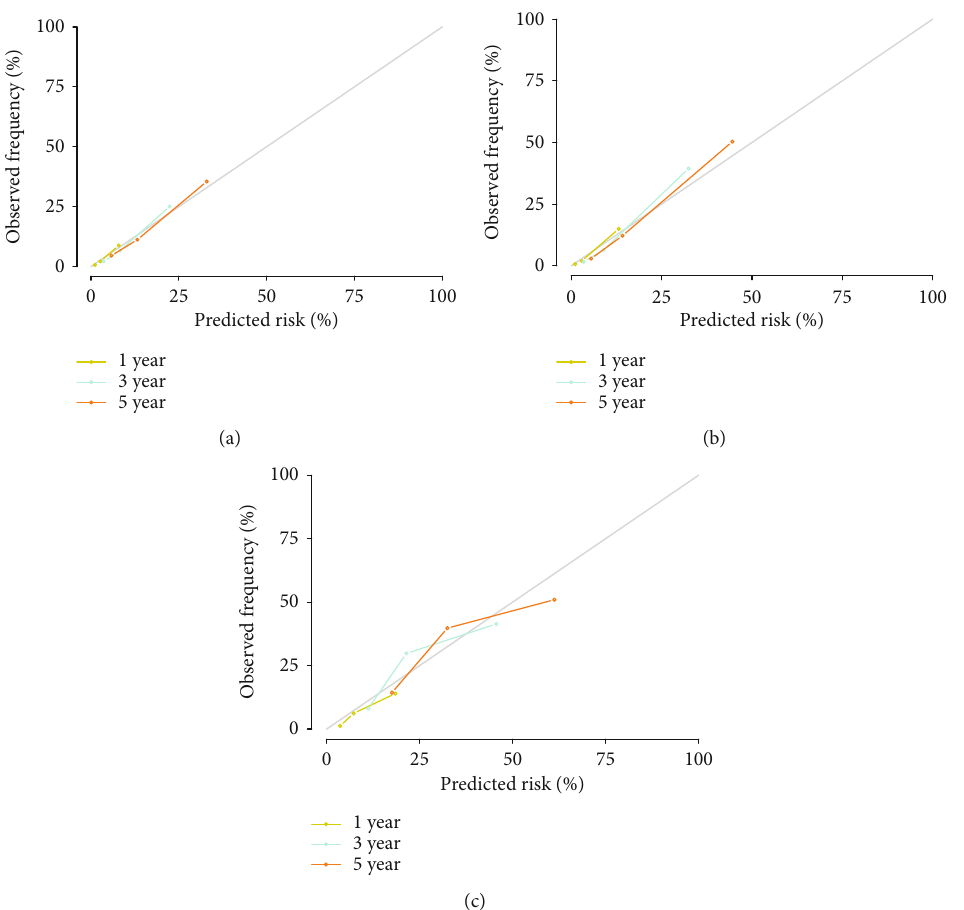
Figure 2: The calibration curves for predicting patient survival at 1-, 3-, and 5-year points in the development cohort (a), validation cohort (b), and test cohort (c). Nomogram-predicted cancer-speci fi c survival is plotted on the x -axis; actual cancer-speci fi c survival is plotted on the y -axis. A plot along the 45-degree line indicates a perfect calibration model, wherein the predicted probabilities are identical to the actual outcomes. Table 3: Comparison of AUC and Brier score between the nomogram and 8 th TNM stage in patients with rectal